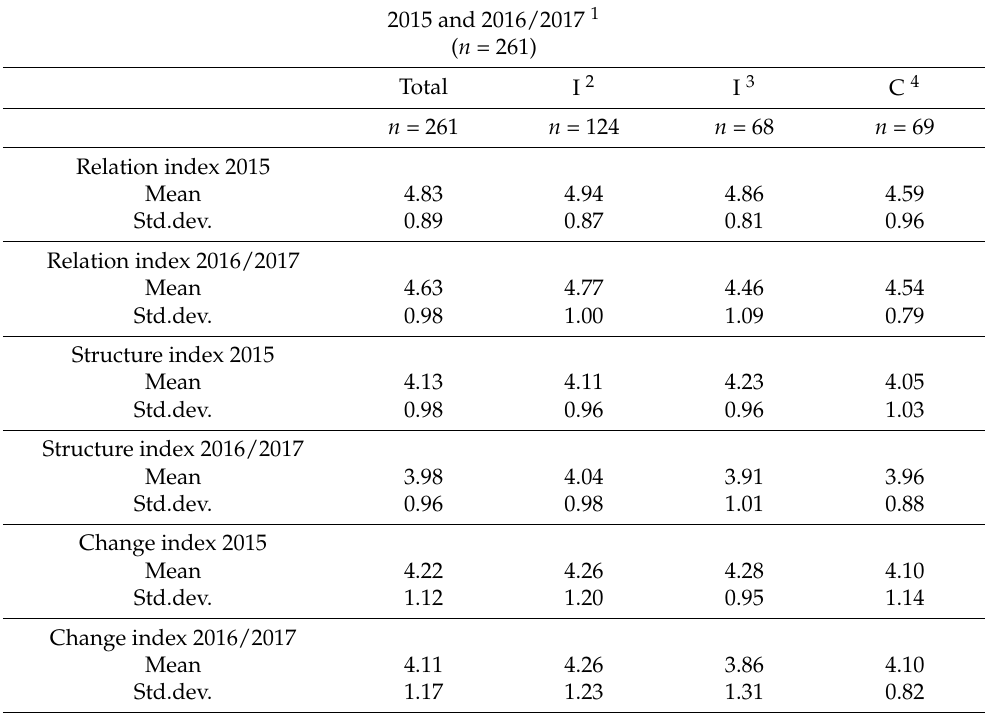
Table 4. Mean and standard deviation for the relation-, structure-, and change-oriented indices for subordinates in 2015 and 2016/2017, n = 261.